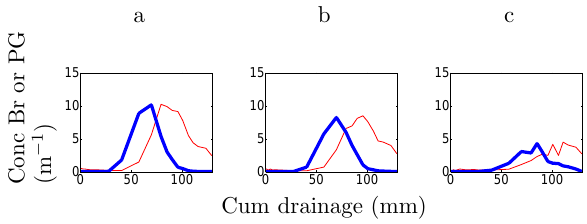
Fig. 10. Breakthrough curves of bromide (thin red line) and PG (thick blue line) for the irrigation experiment, for fast cells (a) , average cells (b) , and slow cells (c) .